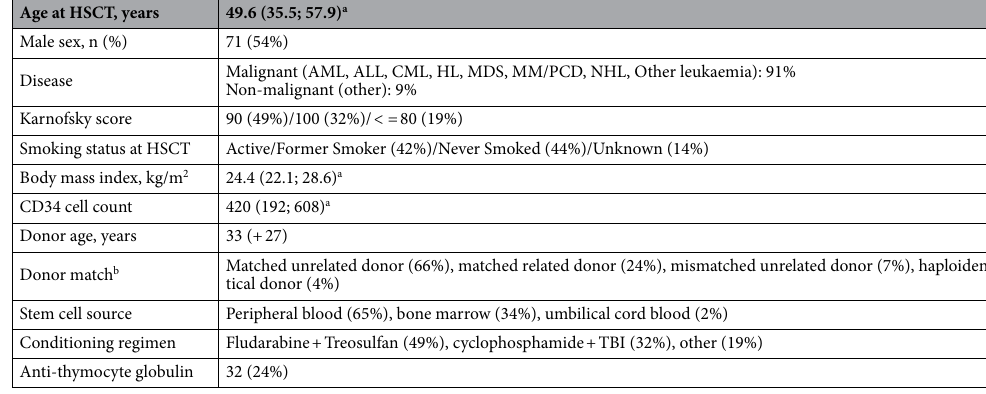
Table 1. Patient and transplant characteristics. a Median (1st quartile; 3rd quartile). b Matched = 9/10 or 10/10 HLA allele match, mismatched = one or more HLA antigen mismatches.